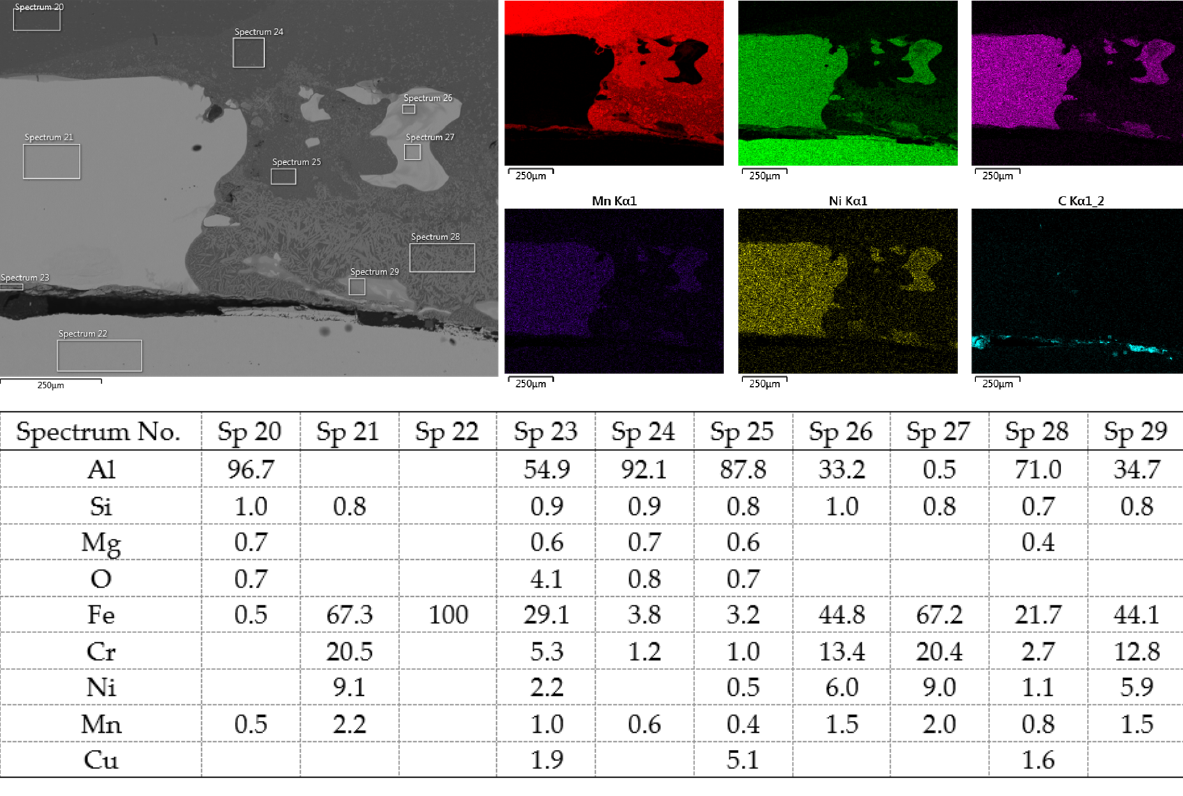
Figure 21. SEM analysis of Al-DC connection, distribution element maps and EDX spectra-detail. At the interface between DC and the Al melt, regions with a needle-like structure are present (spectrum 28), which, according to [36,37], could correspond to Fe 2 Al 5 or other phases, e.g., FeAl 3 , FeAl 2 , FeAl or Fe 4 Al 13 . From the point of view of bond strength, it is desirable that there are no IMCs at the Fe-Al interface, or that they are as thin and discon- tinuous as possible. 4.2. SEM Analysis of Al-TL Connection A simpler interface structure without needle-like formations can be observed when joining Al to galvanized HSLA steel (Figure 22).